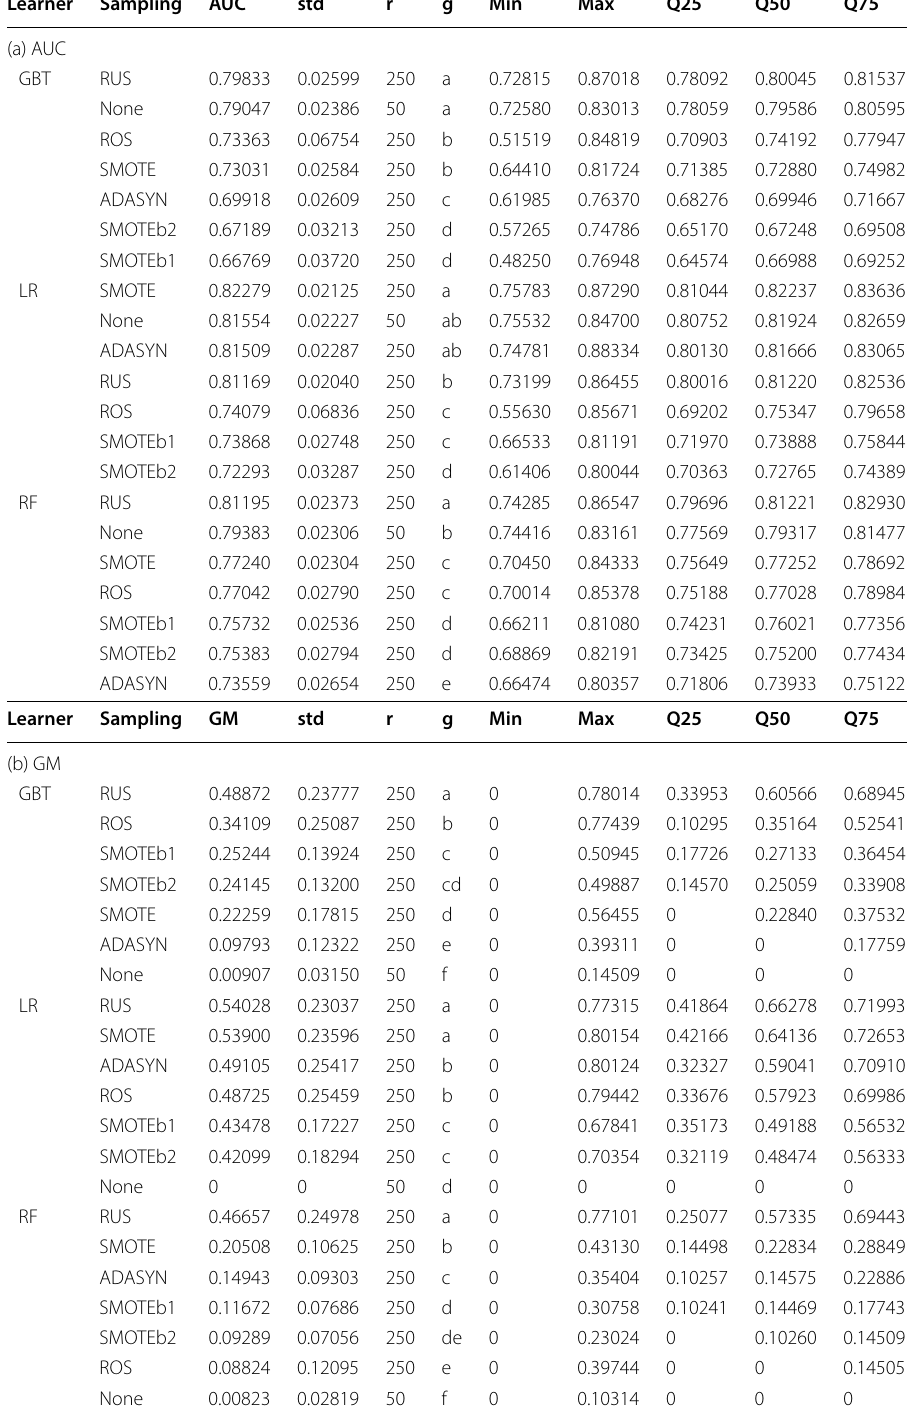
Table 6 Case 1: Medicare-Tukey’s HSD test